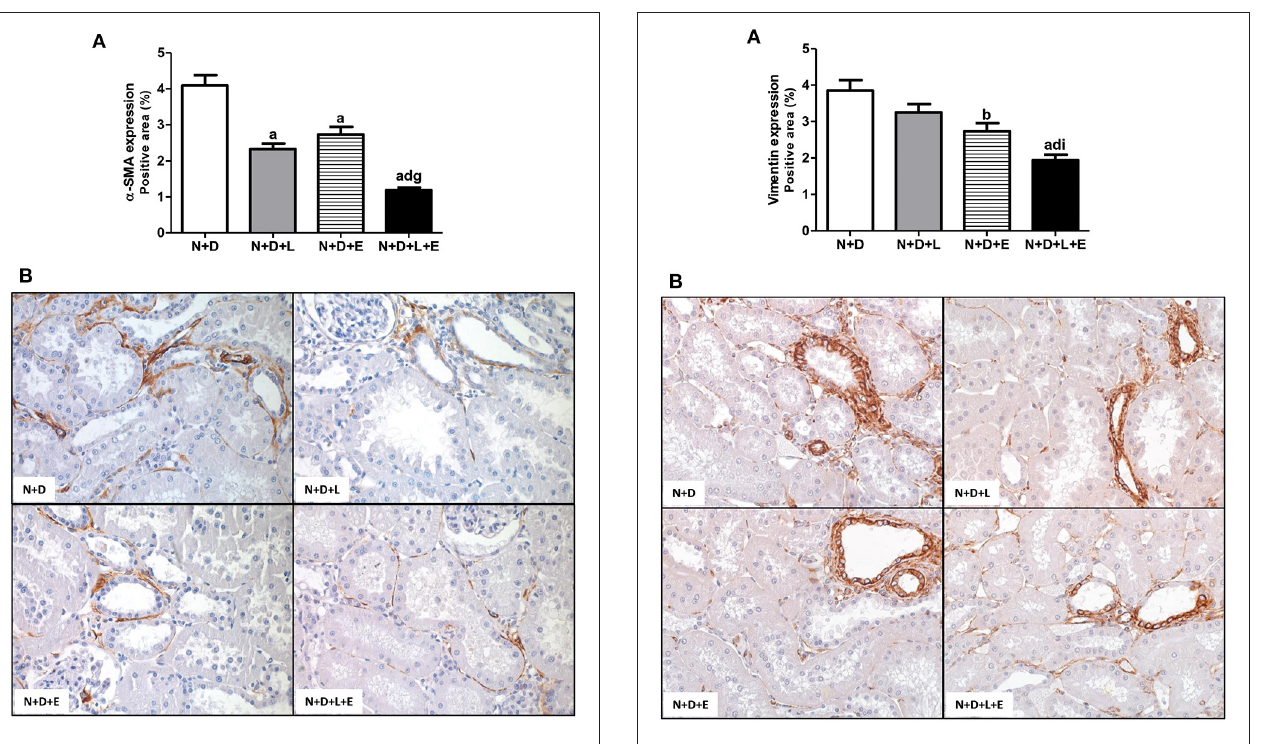
FIGURE 9 | Immunohistochemical analysis of vimentin expression in the renal cortex. (A) Bar graph of vimentin expression evaluated 60 days after 5/6 nephrectomy in vitamin D- deficient rats treated with losartan, erlotinib or losartan + erlotinib. (B) Representative photomicrographs of immunostaining for vimentin in the renal cortex from a N + D, N + D + L, N + D + E, and N + D + L + E rat (x400). Note that vimentin expression is significantly lower in the N + D + L + E than in the other groups. Data are mean ± SEM. a p < 0.001, b p < 0.01 vs. N + D; d p < 0.001 vs. N + D + L; i p < 0.05 vs. N + D + E. N, 5/6-nephrectomized rats; D, vitamin D-deficient rats; L, losartan-treated rats; E, erlotinib-treated rats; L + E, rats concomitantly treated with losartan + erlotinib. N + D ( n =